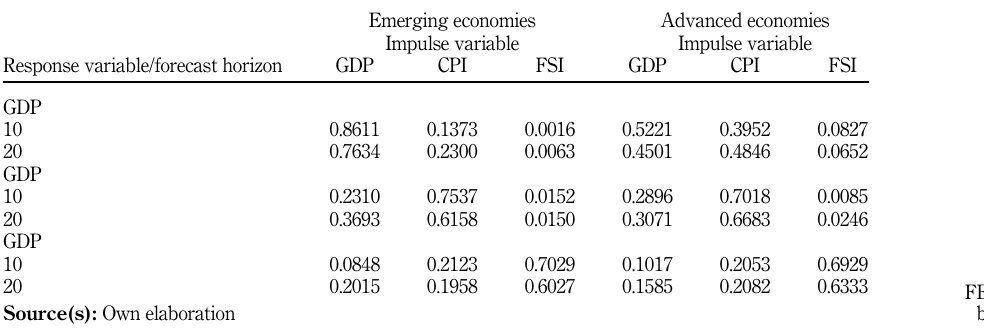
Figure 2. IRFs of the three- variable model for emerging